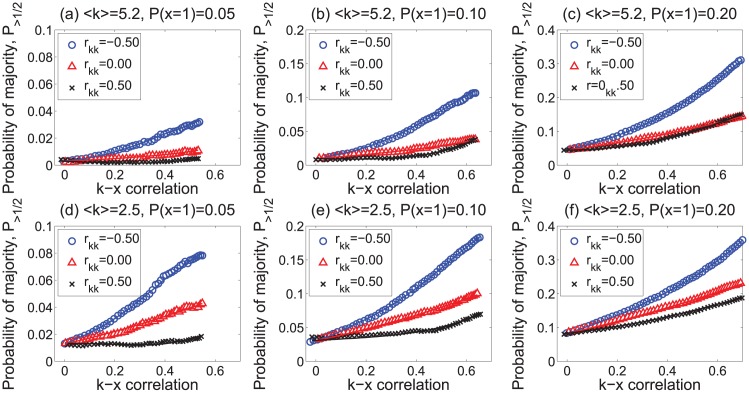
“Majority illusion” in random networks.Magnitude of the illusion in Erdős-Rényi-type random networks as a function of degree–attribute correlation ρkx and for different values of degree assortativity rkk. Each network has 10,000 nodes with 〈k〉 = 5.2 (top row) or 〈k〉 = 2.5 (bottom row), and different fractions of active nodes. The lines represent calculations using the statistical model of Eq (5).